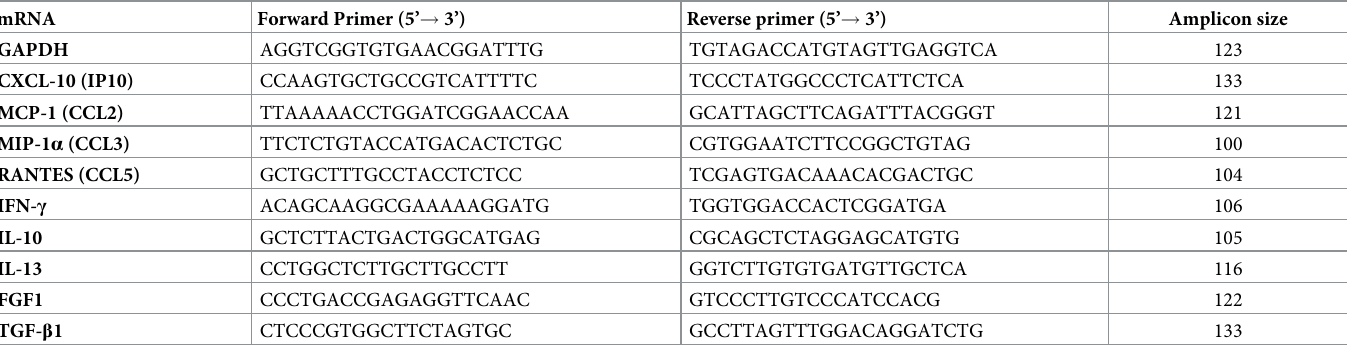
Table 1. Mice primers used for